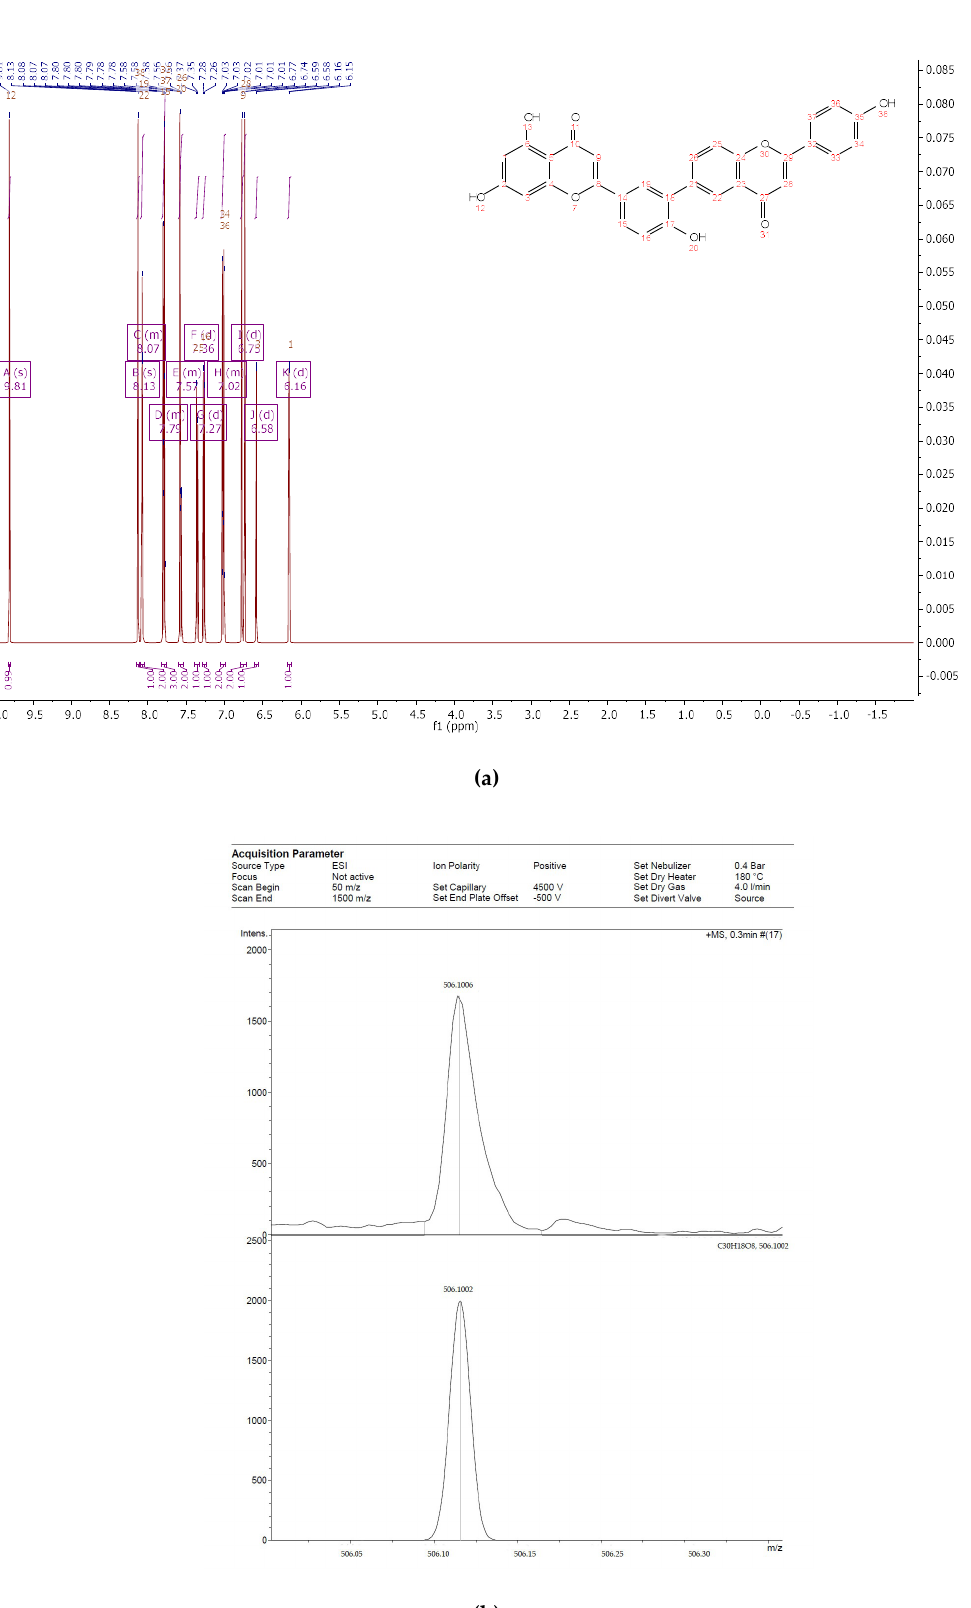
Figure 4. 1 H NMR (a) nd HRMS ( b ) spectrum of 2-(3,4-dimethoxyphenyl)-5,7-dimethoxychroman-4-one from extracts of callus, cell suspension, and root cultures of Rhodiola rosea .